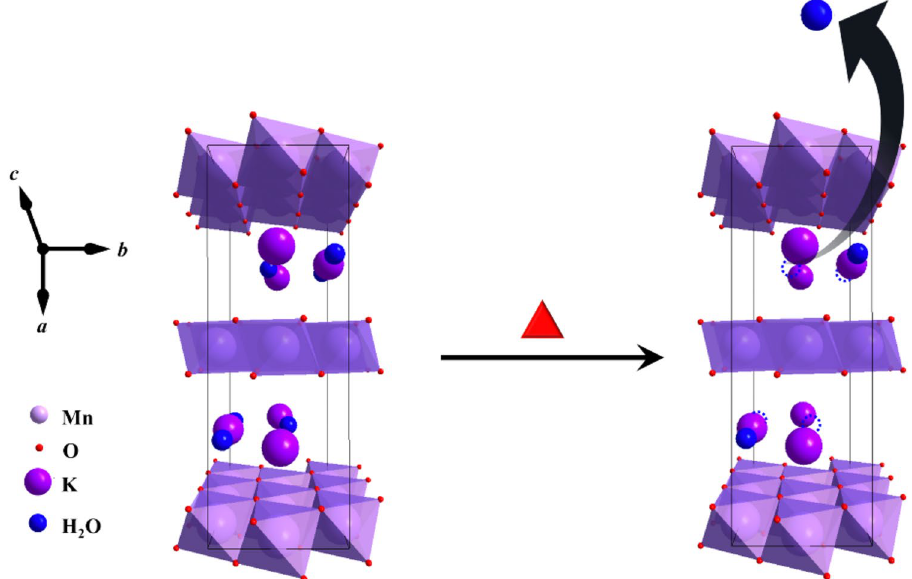
Figure 5. Schematic illustration of the proposed mechanism for the increase in the BET surface area of δ -MnO 2 after annealing. The structure corresponds to a single unit cell of orthorhombic δ -MnO 2 .